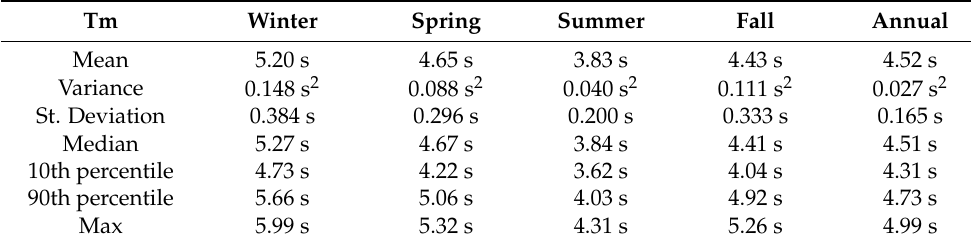
Table 4. Tm seasonal statistic parameters. Right-side column reports the annual